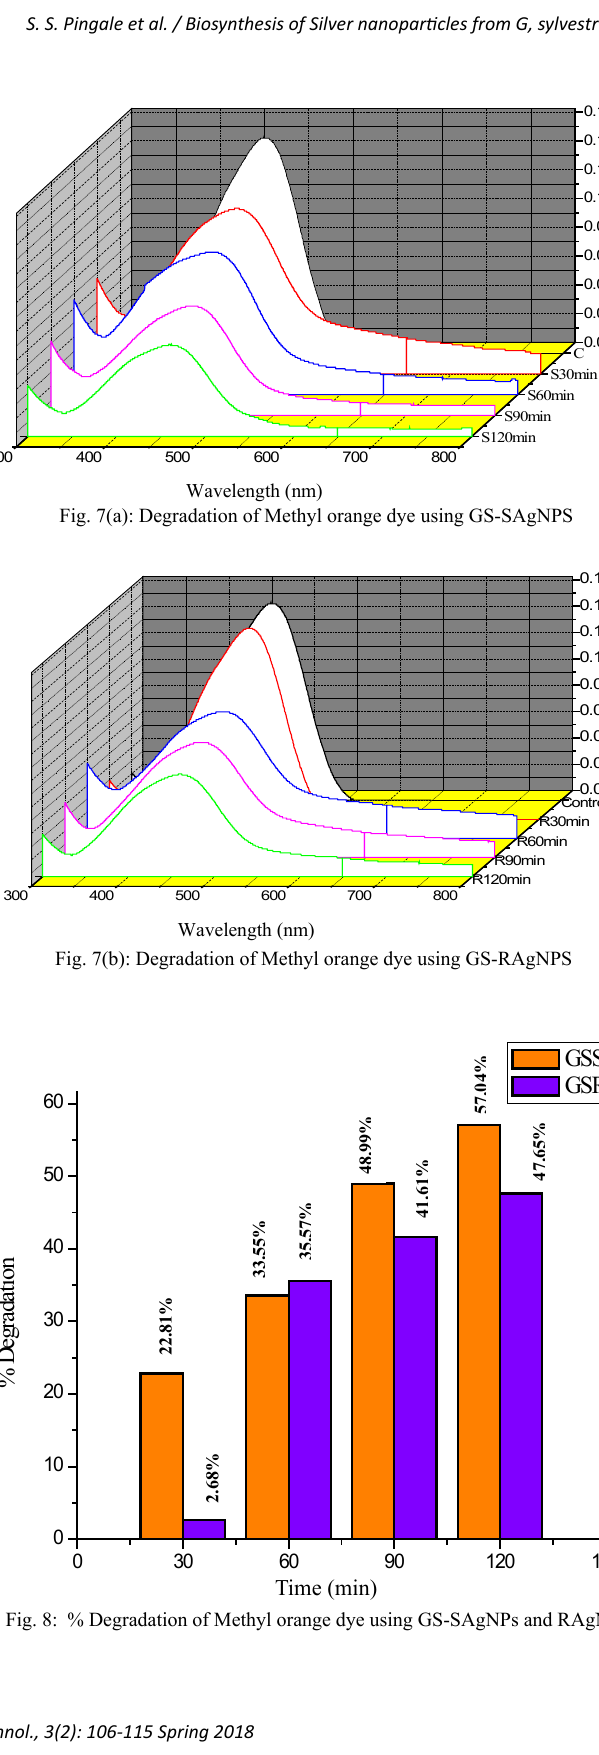
Fig. 7(a): Degradation of Methyl orange dye using GS-SAgNPS